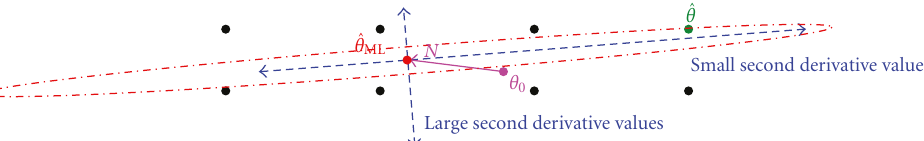
Figure 4: Illustrate properties of the grid-based approach to (cid:3) θ ML . Here, θ 0 is the actual parameter value, (cid:3) θ ML is the true minima due to noise N , and (cid:3) θ is the minima on the grid and hence the ML estimate based on the grid-based approach. The figure does not use a rotated grid to adjust to the principle axes of the FIM schematically represented by the dashed-line axes in the figure.